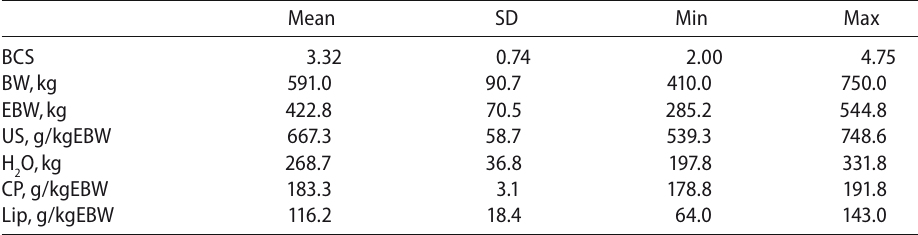
The values of the parameters examined for the second sampling Mean SD Min Max BCS 3.30 0.71 1.75 BW, kg 592.7 81.7 686.7 270.3 183.3 113.5